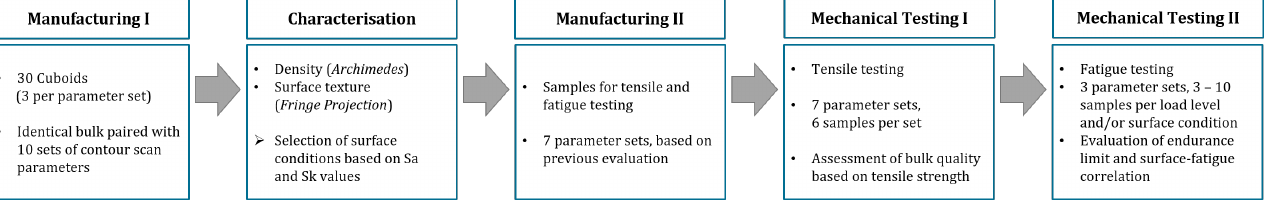
Figure 3. Workflow